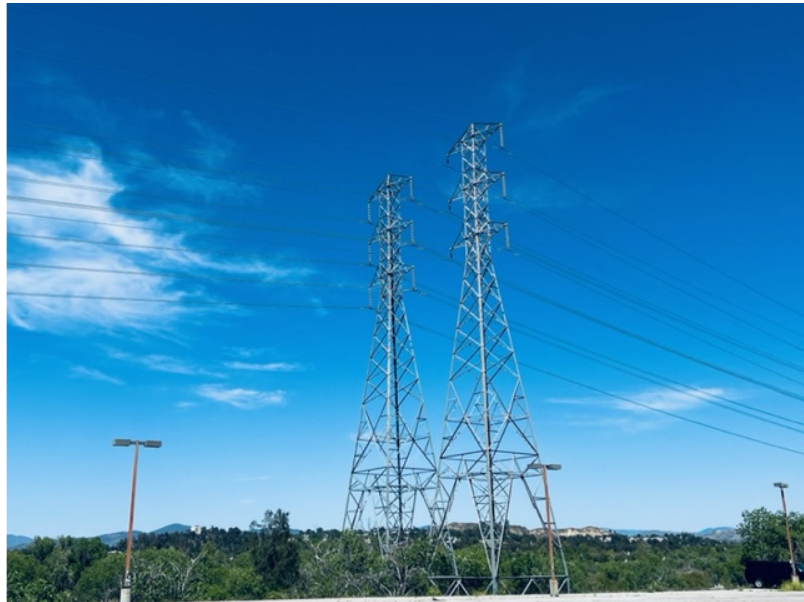
Figure 1. Parallel transmission power lines in a suburban area in Santa Clarita, CA.